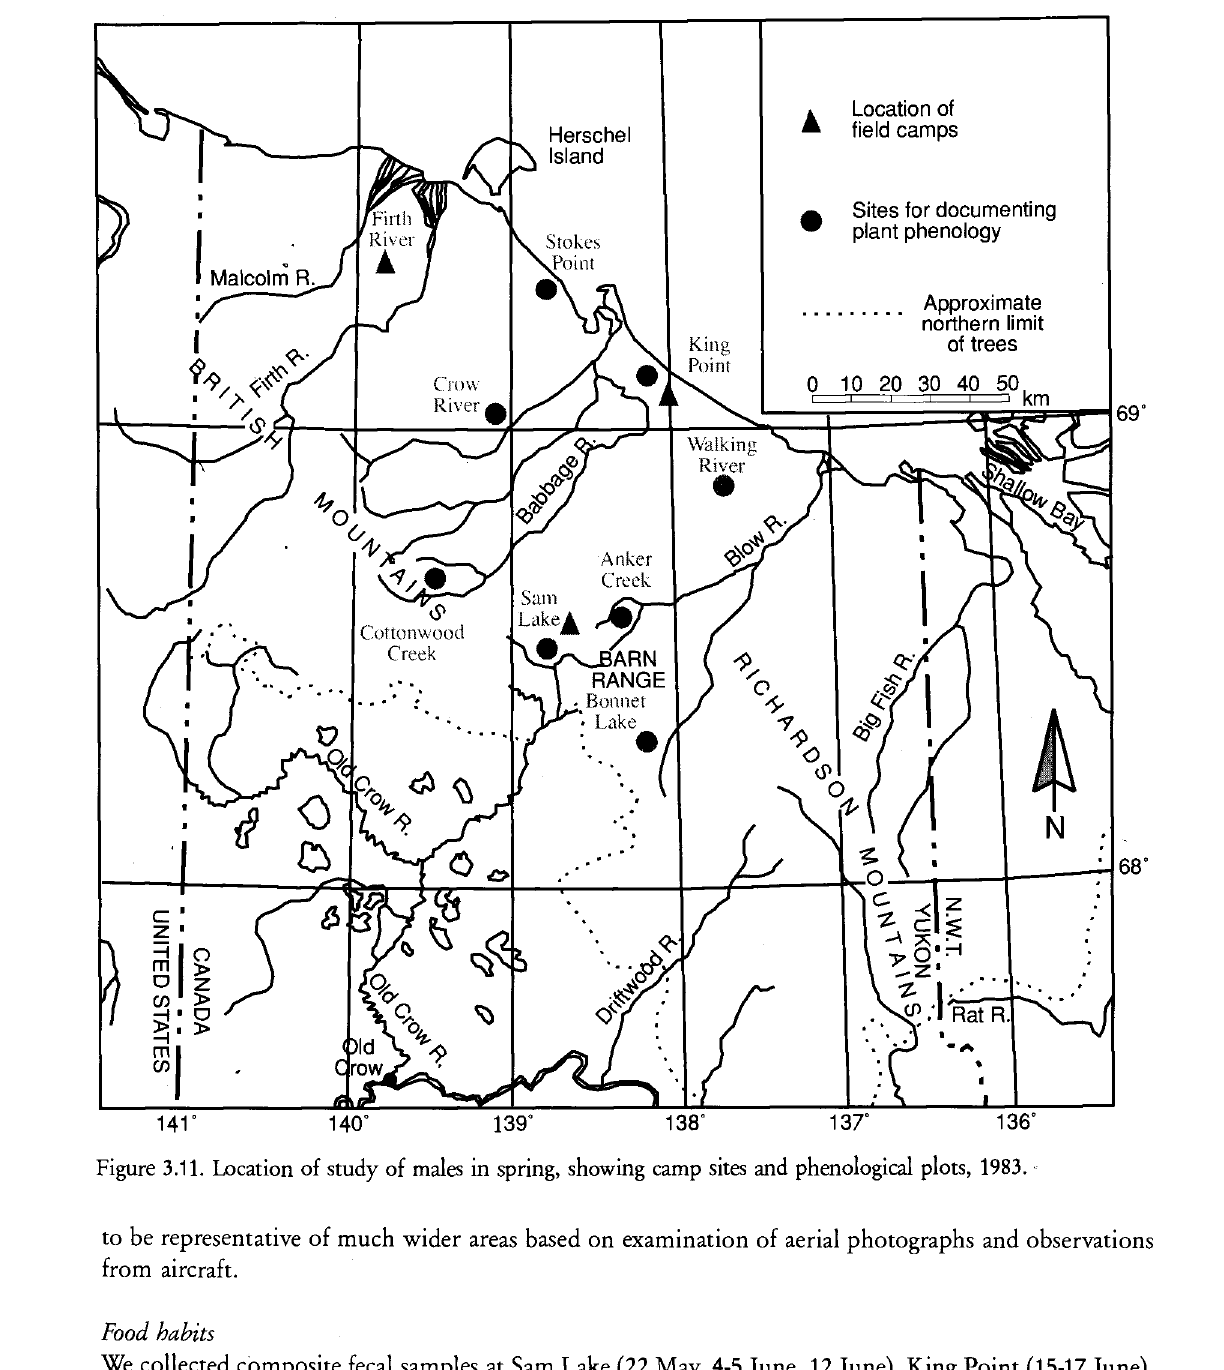
to be representative of much wider areas based on examination of aerial photographs and observations from